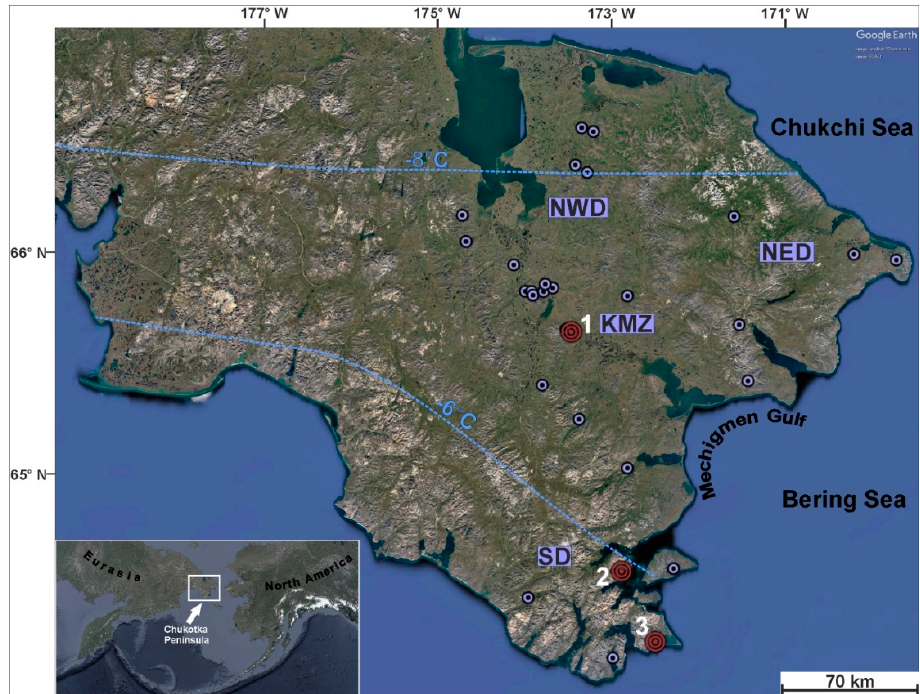
Figure 1. Location of hot spring groups found in the Chukotka Peninsula. Numbers 1, 2, and 3 indicate the Mechigmen, the Senyavin, and the Chaplino thermal groups, respectively. Isolines mean annual air temperatures. Different areas are shown as abbreviations SD (southern), NED (north-eastern), NWD (north-western), and KMZ (Kolyuchin–Mechigmen Zone).